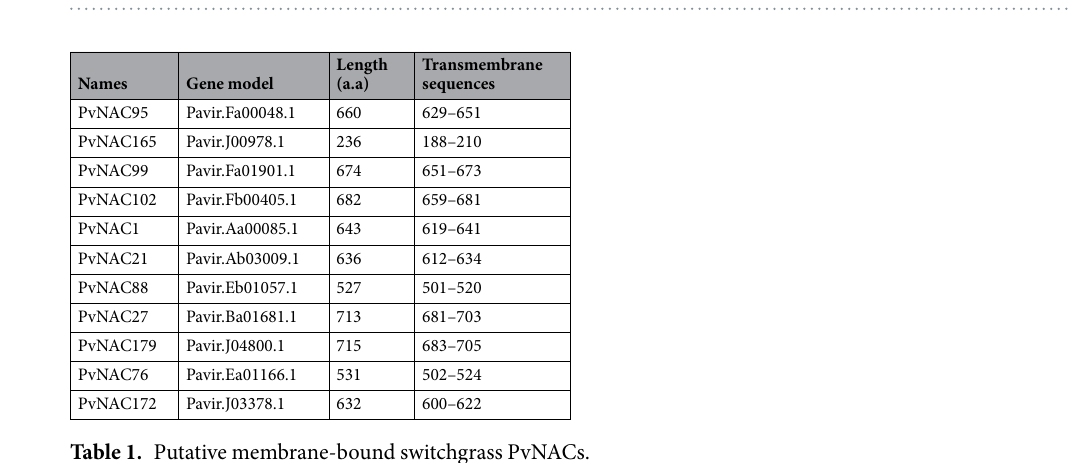
Figure 1. Phylogenetic relationships show the PvNACs that are orthologous to annotated AB- or stress- responsive NAC genes in rice and Arabidopsis . ( a ) PvNAC249 and PvNAC216 were orthologous to Os11g03310.1. ( b ) PvNAC41 was orthologous to Os08g339910.1. ( c ) PvNAC208 and PvNAC185 were orthologous to Os11g03300.1 and Os12g03040.1. ( d ) PvNAC219 was orthologous to Os07g48450.1. ( e ) PvNAC141 was orthologous to Os03g60080.1. ( f ) PvNAC239 and PvNAC174 were orthologous to ANAC002, ANAC032, Os05g34830.1, and Os01g66120.1.